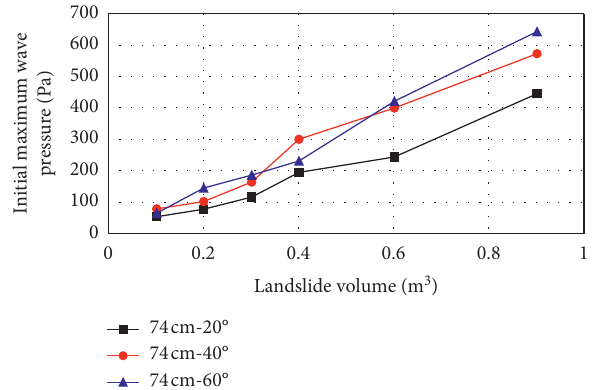
Figure 14: Variation of initial maximum wave pressure with landslide volume under different slope angles (at 74cm).